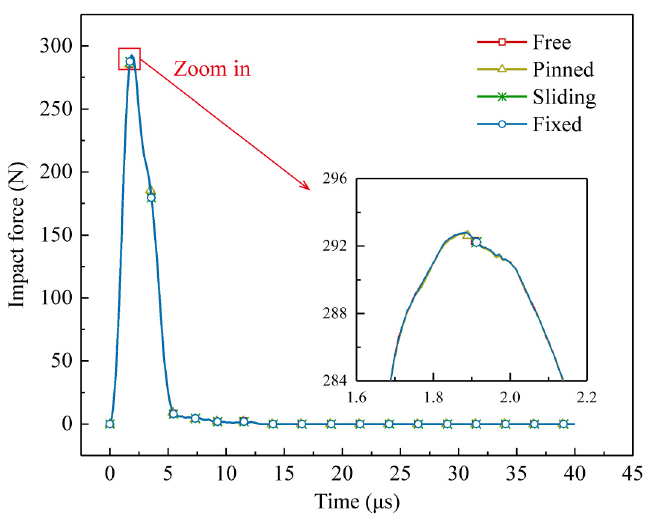
Figure 6. Boundary conditions.